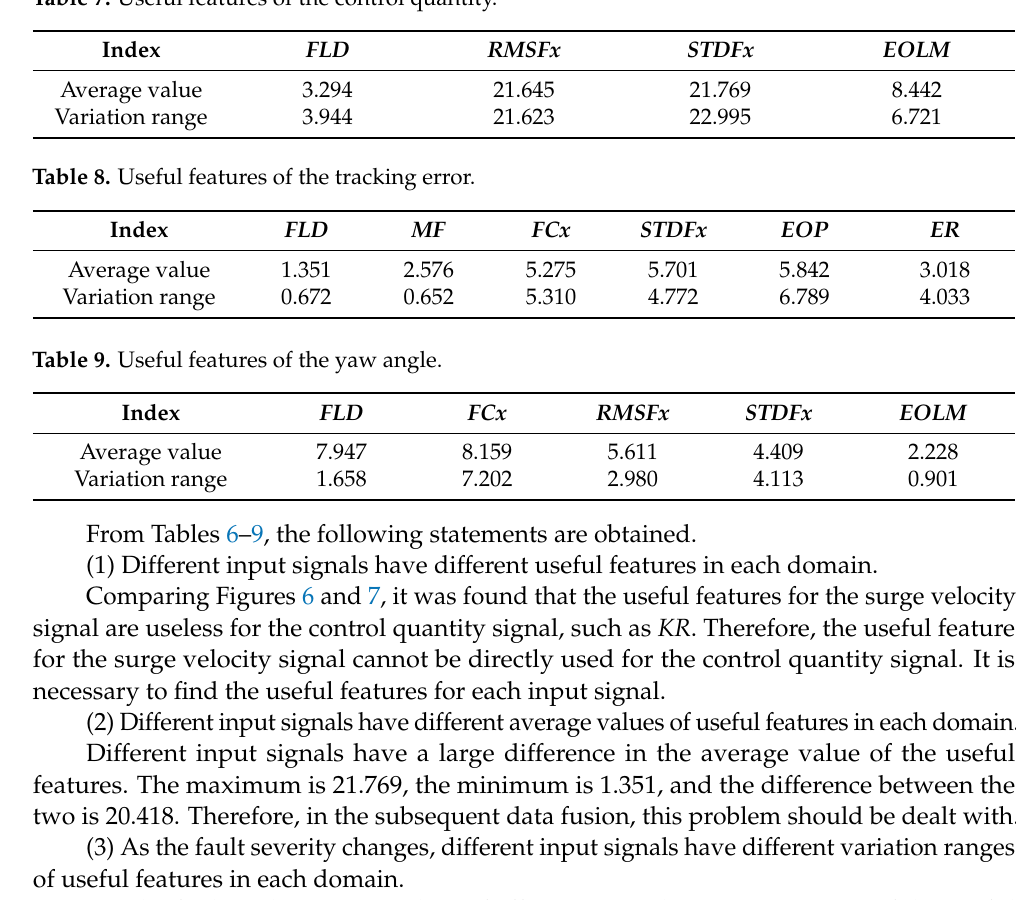
Table 7. Useful features of the control quantity.